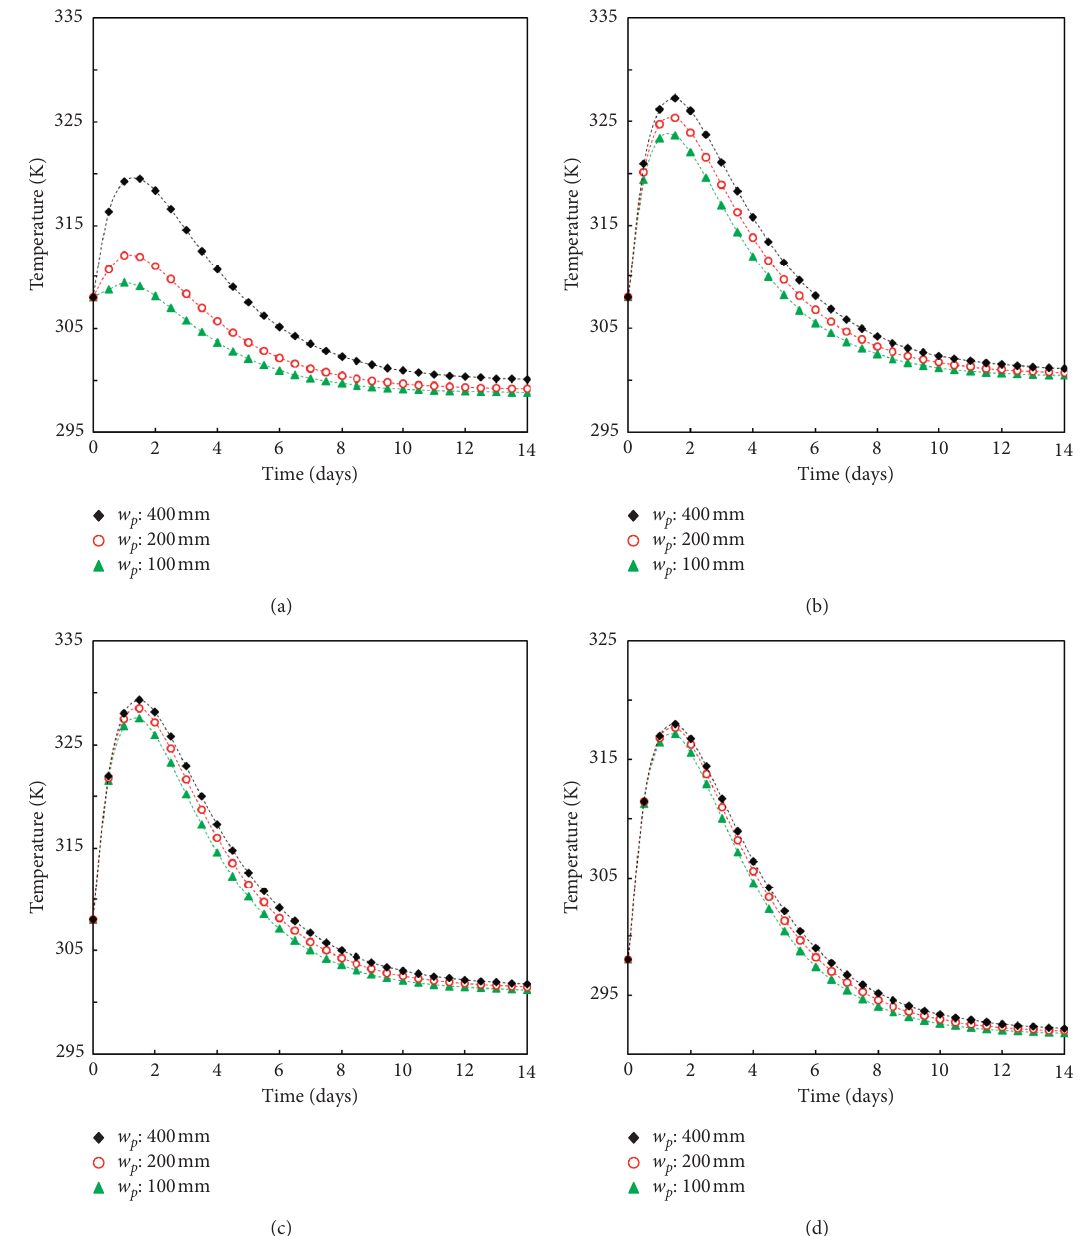
Figure 12: Temperature histories of the points with variation of w